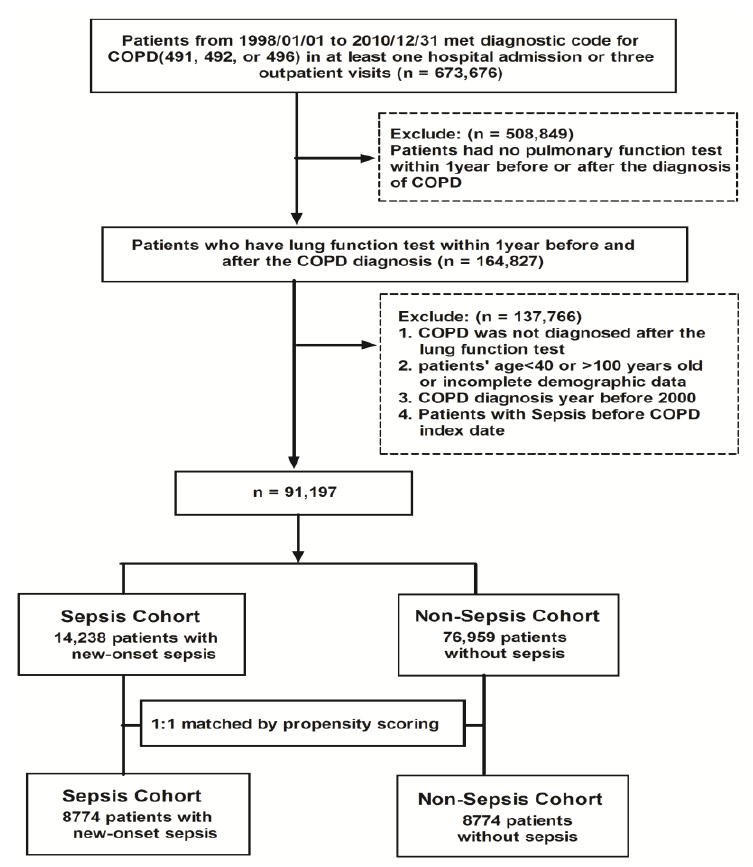
Figure 1. Flow chart of study cohort population selection. COPD: chronic obstructive pulmonary disease.